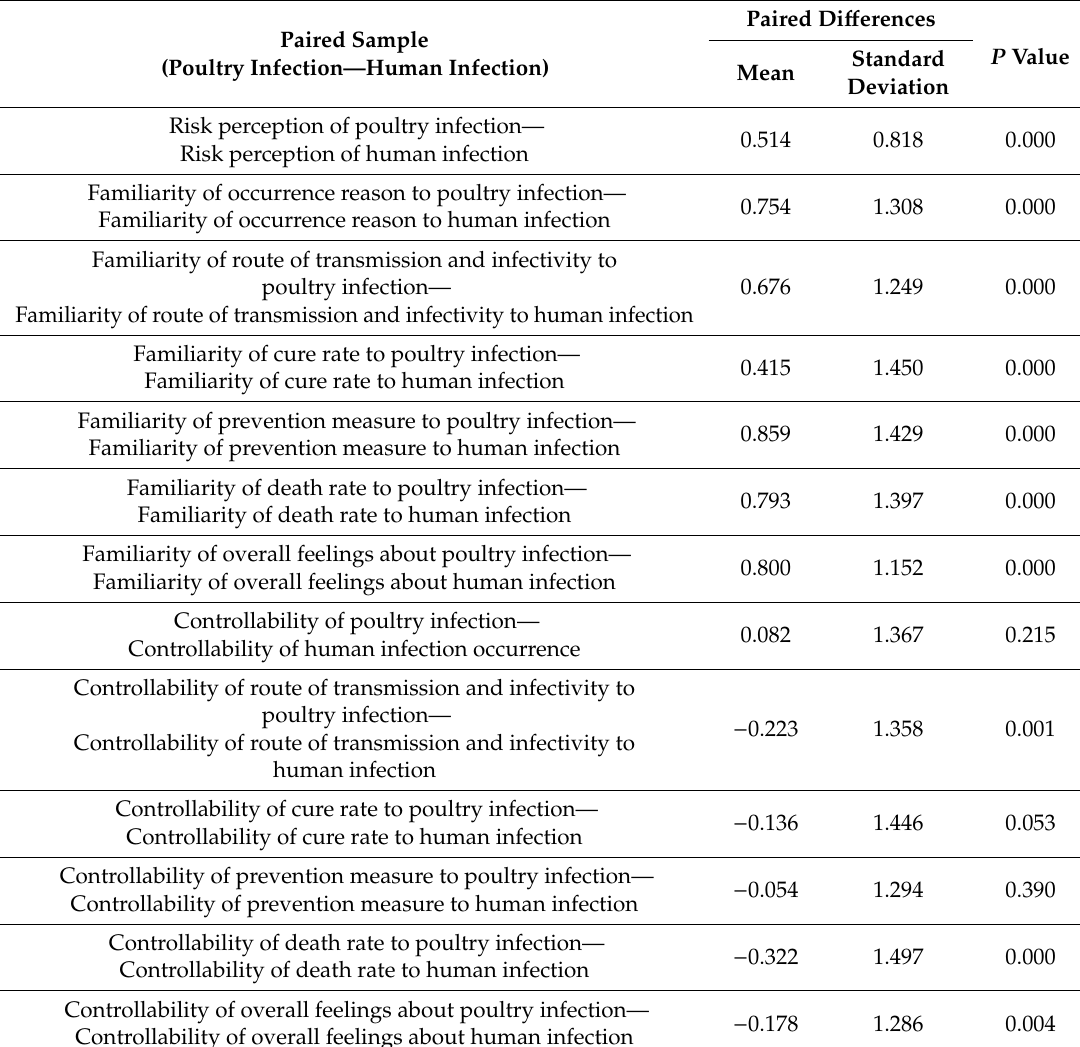
Table 2. Comparisons of risk perception characteristics regarding human infection with A / H7N9 and poultry infection with A /